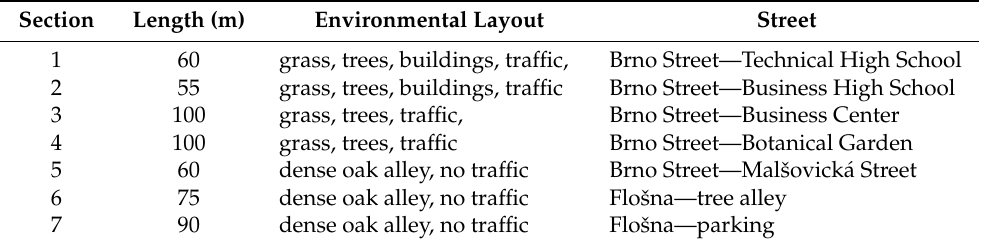
Table 1. Walking route. The description of particular sections where walking speed was measured. For additional route details, see https://maps.google.com, location: Hradec Kralove, Czech Republic, Orlicke nabrezi